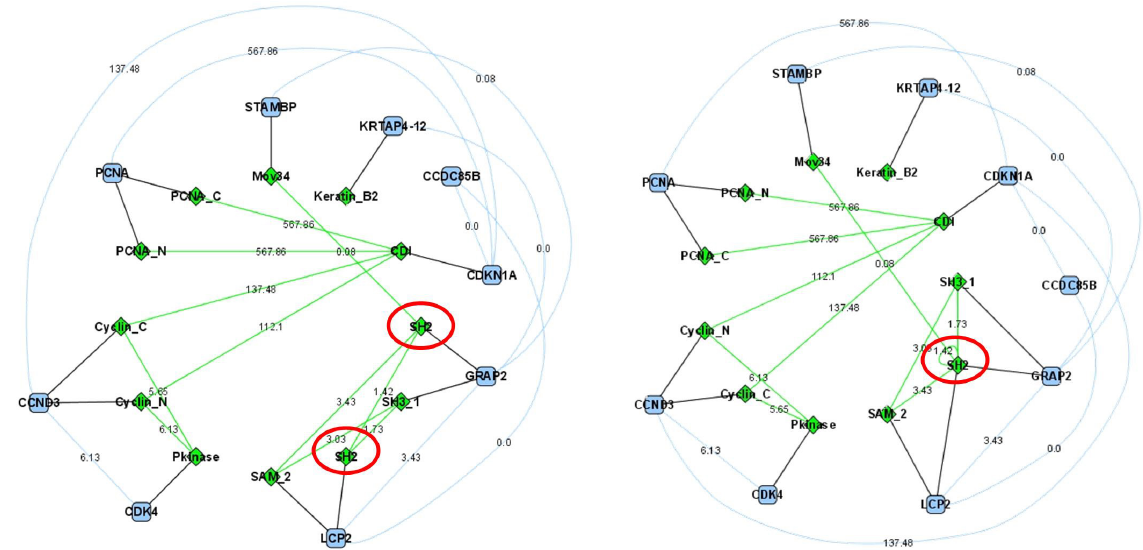
Figure 5: The left-hand side shows the extended view and the right-hand side the compact view of the same domain graph. The SH2 domains (in red circles) of the proteins LCP2 and GRAP2 are displayed separately in the extended view and are merged into a single meta-node in the compact view.